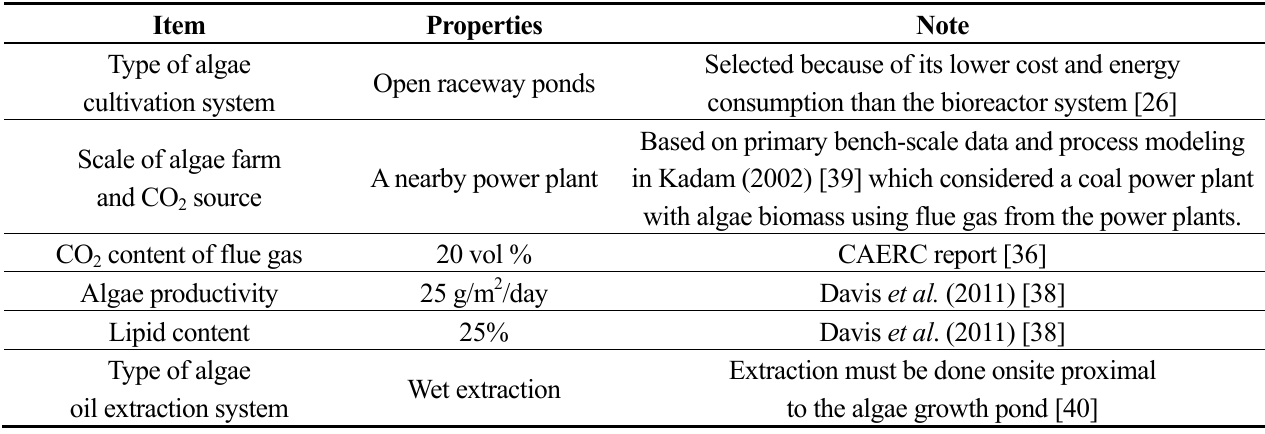
Table 2. Key assumptions for algae cultivation system in